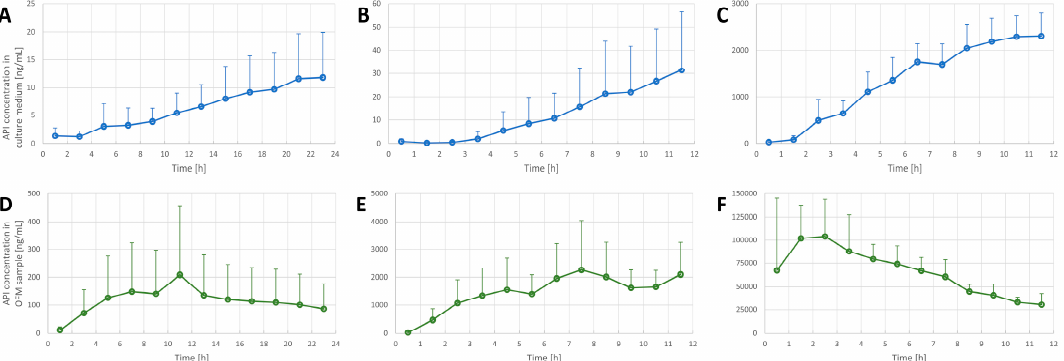
Figure 5. Penetration tests in FTSE (n = 3) using acyclovir ( A , D ), diclofenac ( B , E ) and lidocaine ( C , F ). API concentrations were determined in FTSE culture medium (top row A – C ) and in FTSE tissue by OFM sampling (bottom row D – F ). Data are shown as the mean and SD (only upward error bars are shown for readability).